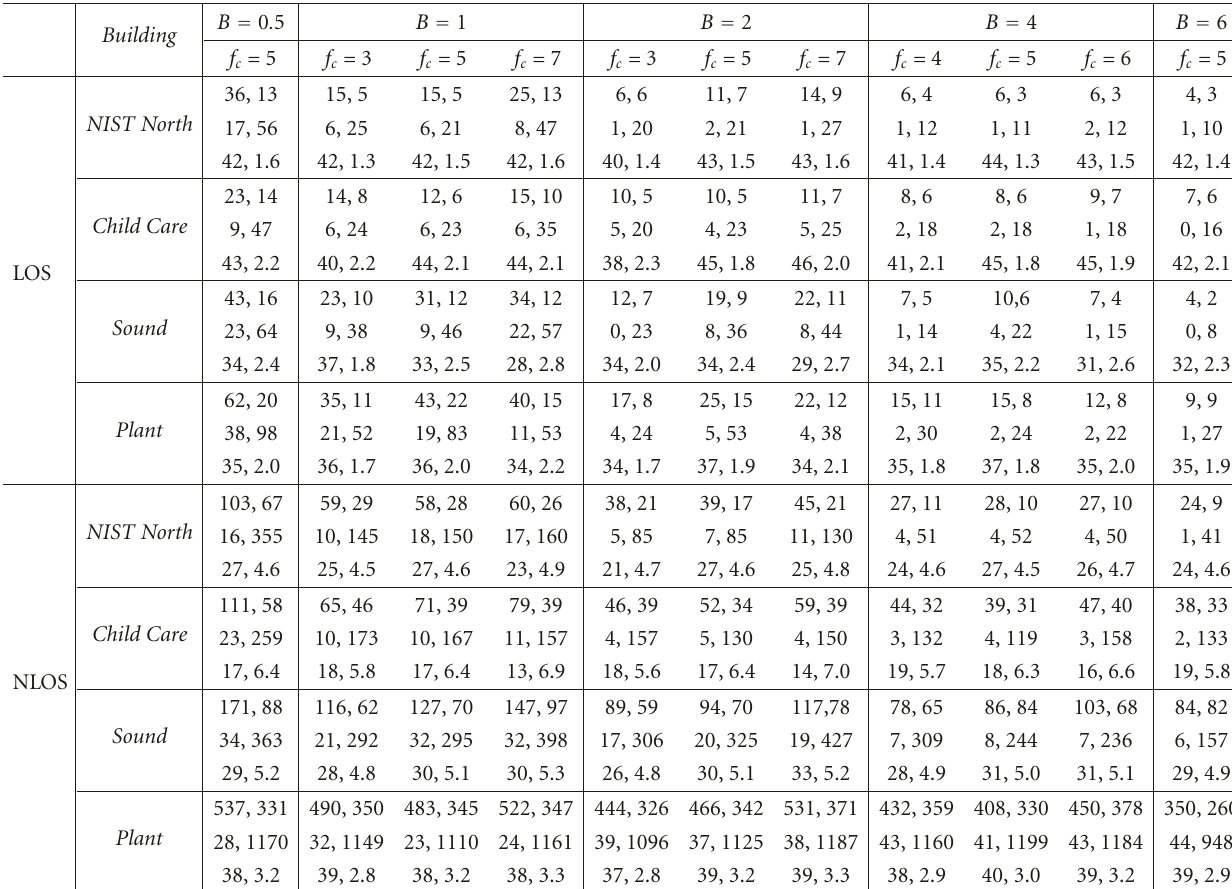
Table 3: Statistical results for